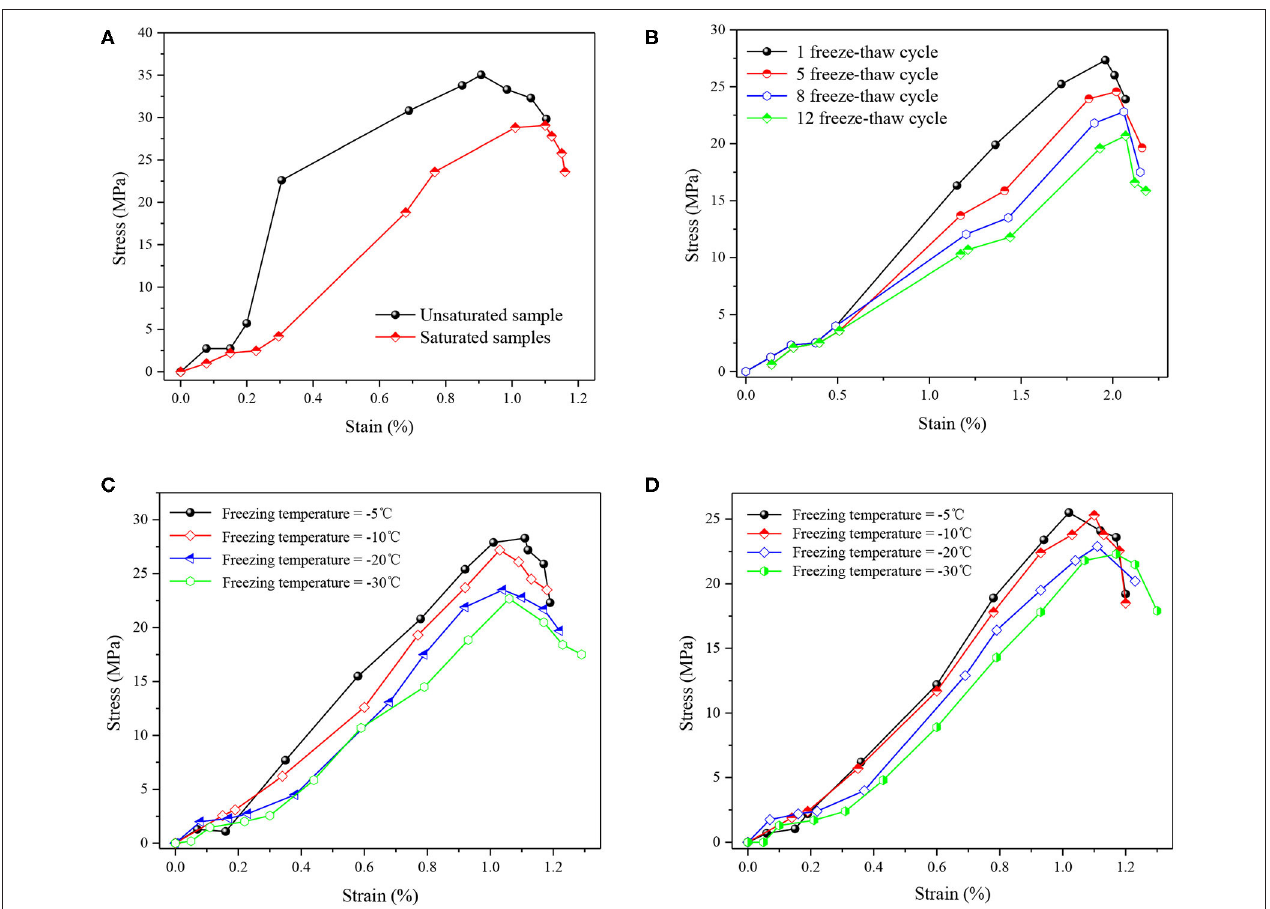
FIGURE 4 | Stress–strain curves of sandstone–concrete composite under different freeze–thaw conditions: (A) freezing temperature = − 10 ◦ C, freeze–thaw cycle = 1; (B) water-saturated specimen, freezing temperature = − 10 ◦ C; (C) unsaturated specimen, freeze–thaw cycle = 1; (D) water-saturated specimen, freeze–thaw cycle = 1.